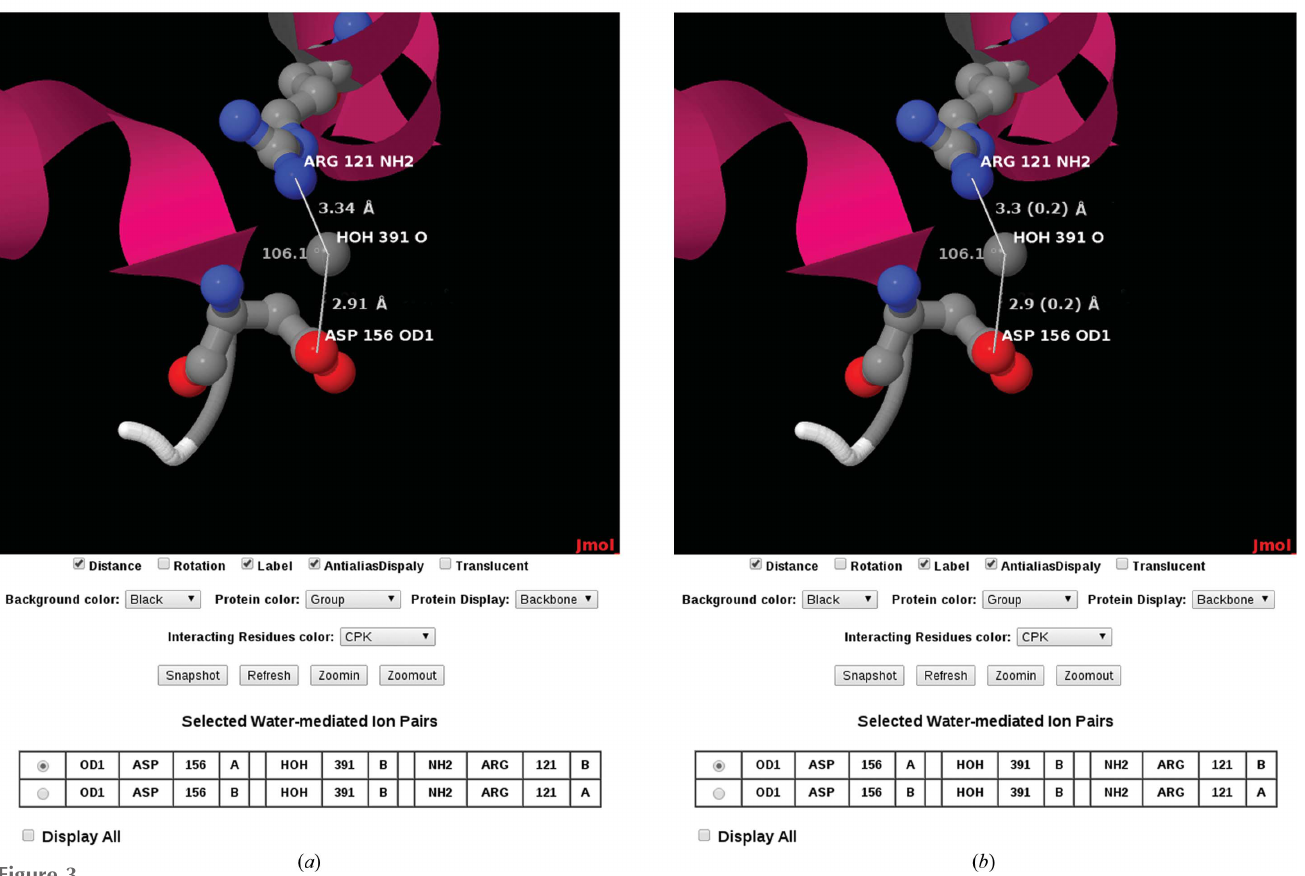
Figure 3 Two water-mediated ion pairs between aspartate and arginine residues (Asp156 O (cid:3) 1 A –HOH391 O–Arg121 NH2 B and Asp156 O (cid:3) 1 B –HOH391 O– Arg121 NH2 A ) of different subunits in PDB entry 1onx. ( a ) Displayed without (cid:5) s and ( b ) displayed with (cid:5) s and an appropriate number of decimal